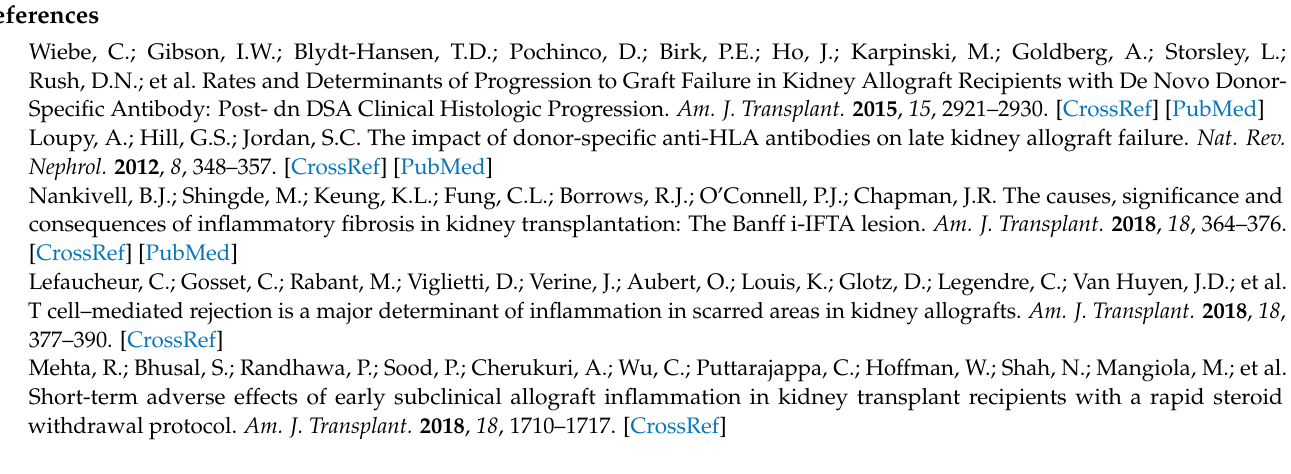
Table S2: Factors associated with occurrence of acute rejection. Table S3: Effect of non-adherence measured by the Morisky scale and immunosuppression regimen on the hazard of acute rejection. Table S4: Factors associated with risk of graft failure. Table S5: Effect of non-adherence measured by the Morisky scale and immunosuppression regimen on the hazard of graft